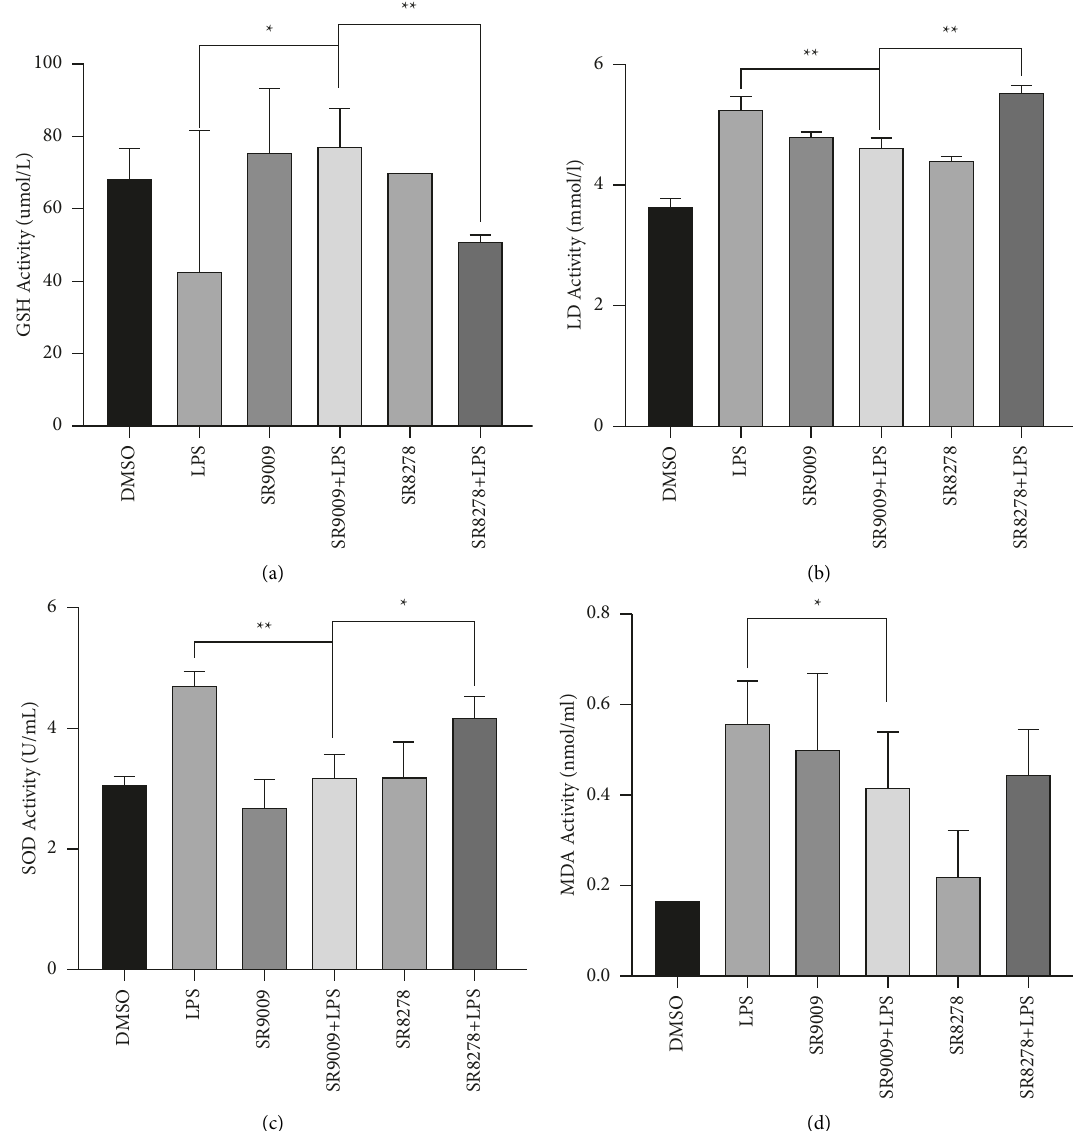
Figure 5: LPS-induced level of oxidative stress in RAW246.7 cells. The expression levels of GSH (a), LD (b), SOD (c), and MDA (d) were detected by ELISA assay. ∗ p < 0 . 05 and ∗∗ p < 0 .